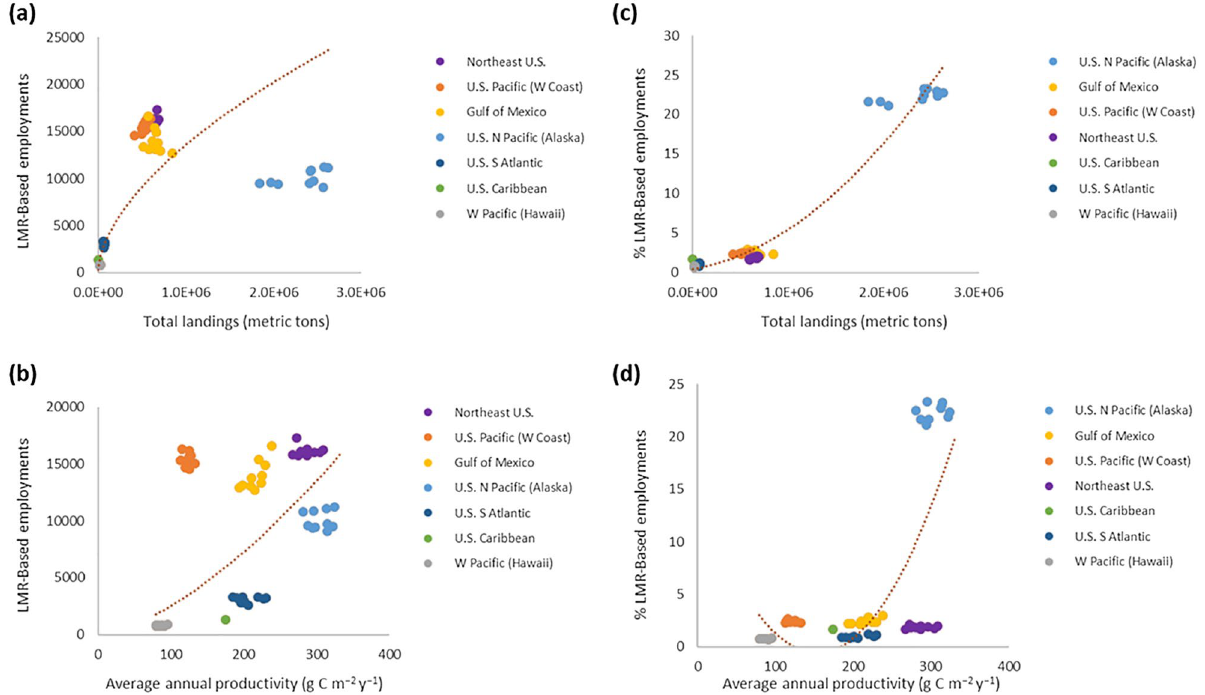
Figure 3. Throughout all major US regions, relationships between living marine resource (LMR)-based employment and percentage of LMR-based employment within the total regional ocean economy as related to total fisheries landings and primary productivity. ( a ) Relationship between total fisheries landings (metric tons) and total LMR-based employment (y = 4.6292x 0.5776 ; r 2 = 0.771; p = 0.006). ( b ) Relationship between total fisheries landings (metric tons) and total LMR-based employment (y = 2.206x 1.53 ; r 2 = 0.388; p < 0.0001). ( c ) Relationship between average annual primary productivity (g C m −2 year −1 ) and percentage of LMR-based employment within the total regional ocean economy (y = 3 × 10 −12 x 2 − 2 × 10 −6 x + 0.3907; r 2 = 0.957; p < 0.0001). ( d ) Relationship between average annual primary productivity (g C m −2 year −1 ) and percentage of LMR-based employment within the total regional ocean economy (y = 0.0006x 2 − 0.1998x + 14.772; r 2 = 0.533; p < 0.0001). Years cover